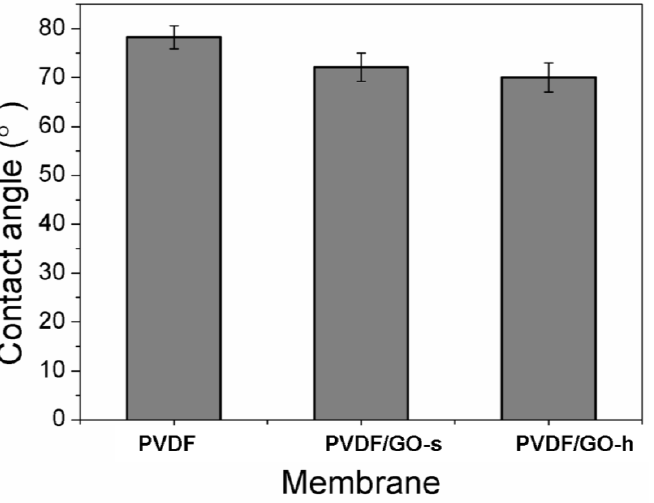
Figure 4. Water contact angles of PVDF, PVDF/GO-s and PVDF/GO-h membranes.